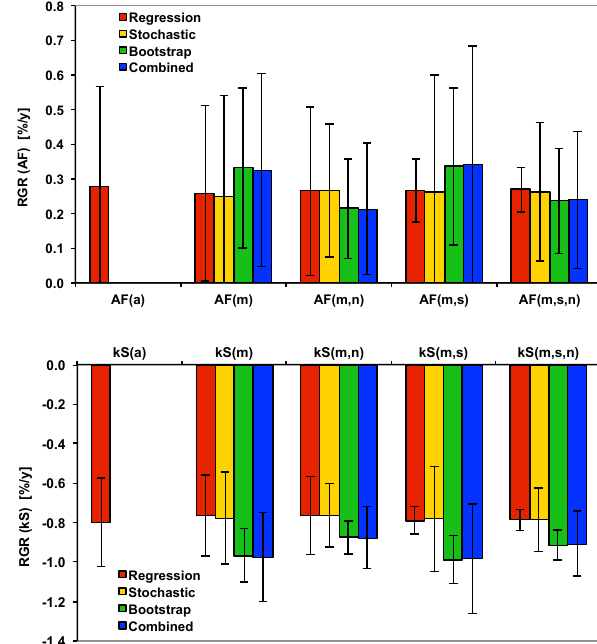
Figure 2 (source: aaTrendEstimation.Results.V34.xls) Figure 2. Estimates of RGR ( AF ) and RGR (k S ) over 1959.0– 2013.0, from five data treatments and four trend estimation meth- ods. Error bars show ± 1 σ confidence intervals. Trends are esti- mated using Eq. (A2). P values for trend significance are given in Tables 1 and 2. Data treatments are described in detail in Ap- pendix C1, and trend estimation methods in Appendix A. Best trend estimates in the text are from the combined method applied to data treatment ( m , s , n ), the rightmost blue bar in each